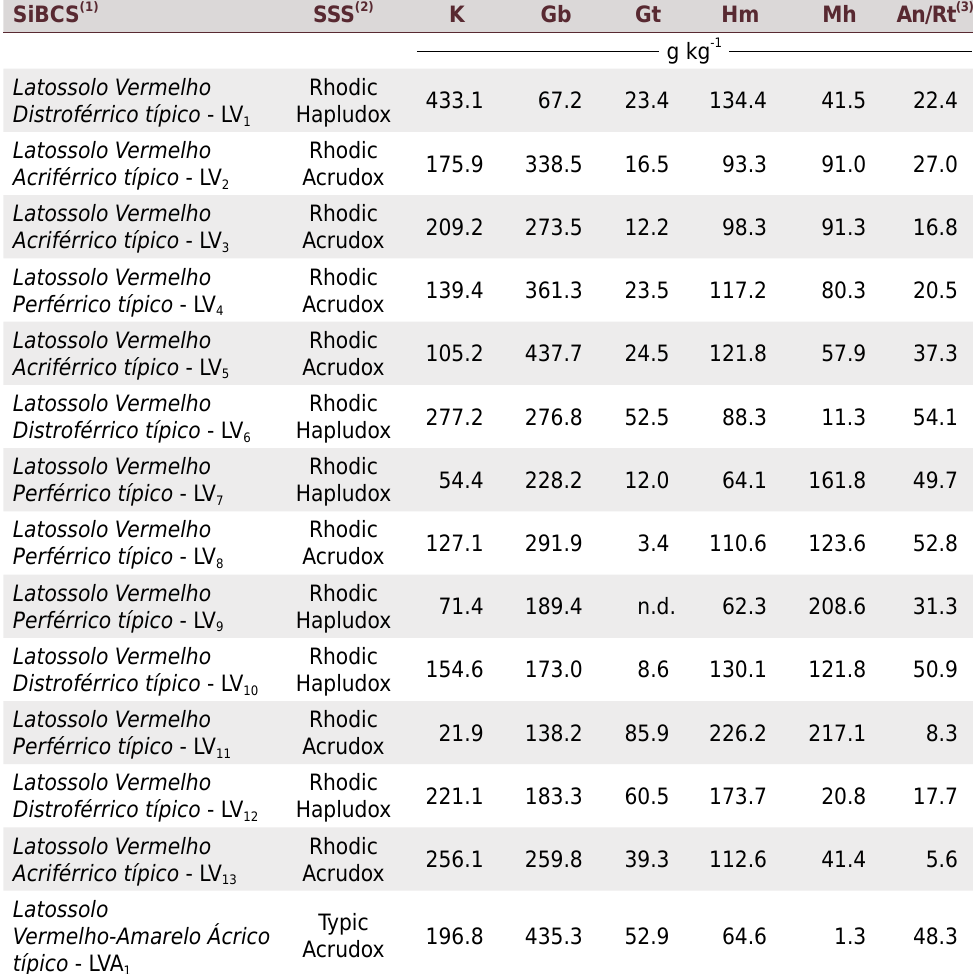
Table 1. Soil classification according to the Brazilian System of Soil Classification – SiBCS and U.S. Soil Taxonomy (SSS) and quantitative estimate of the mineralogical assemblage of the clay fraction SiBCS